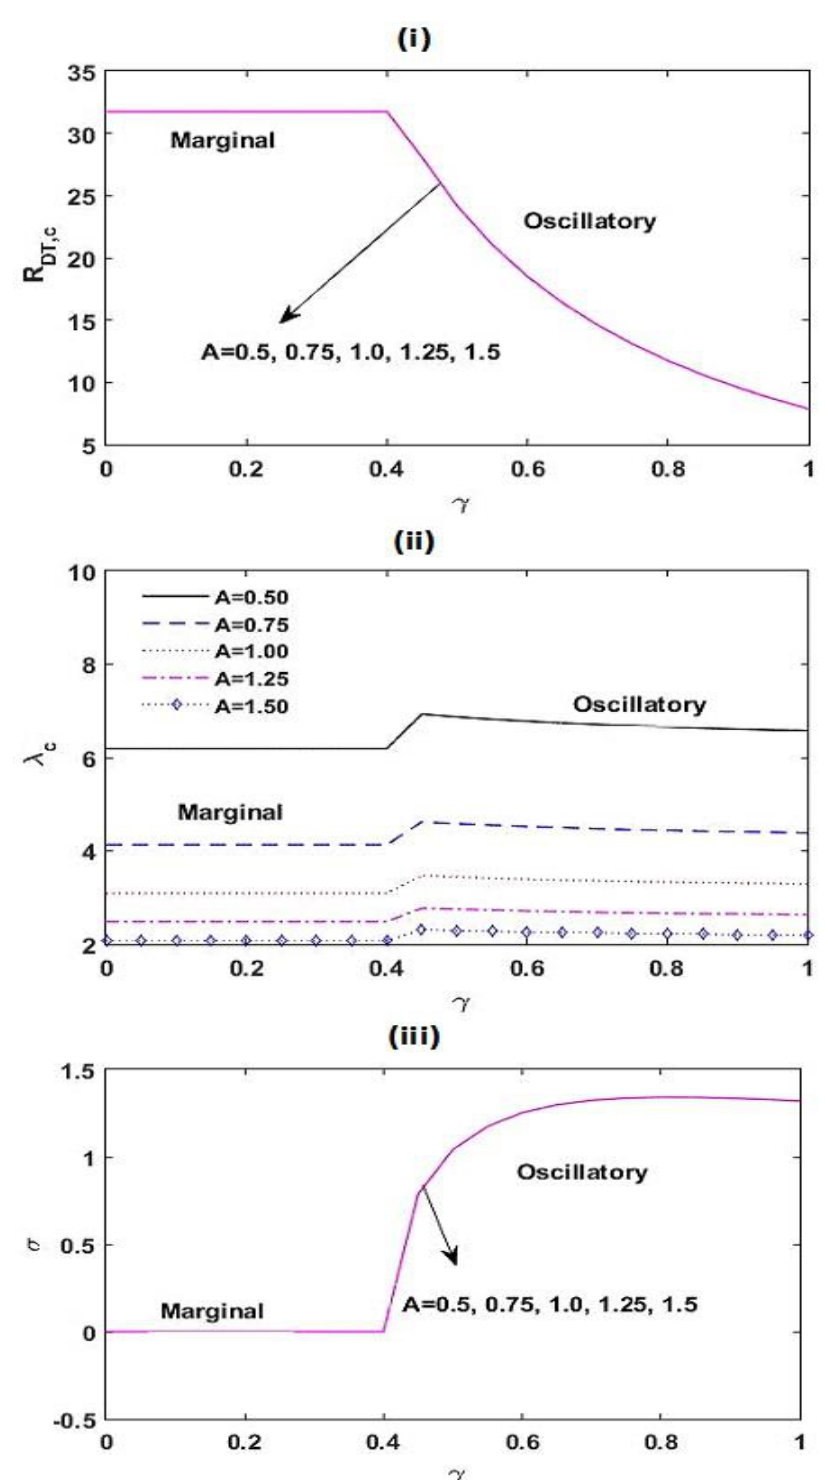
 , and  with  for different values of A at 2 Le = , R , Figure 8. Variation in R DT , c , λ c , and σ with γ for different values of A at Le = 2, m = 1.5, A = 1, Figure 8. Variation in c , DT c R DS = 3, S N = 0.5, K RN = 0.5, and Va = 1.5 m =